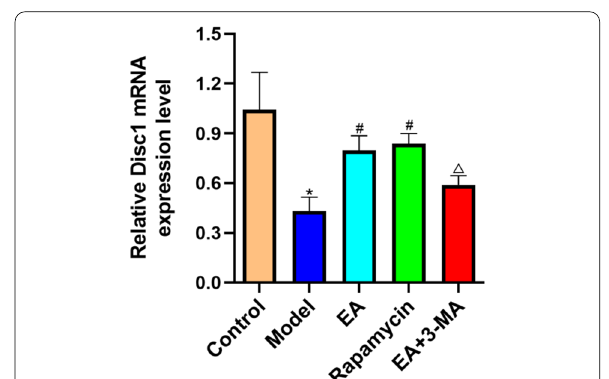
Fig. 9 Effect of EA on the mRNA expression of Disc1 in diabetic rats determined by fluorescence quantitative PCR. Data are expressed as mean standard error of the mean ( n 8 in each group). * p < 0.05 ± = versus control group; # p < 0.05 versus model group; △ p < 0.05